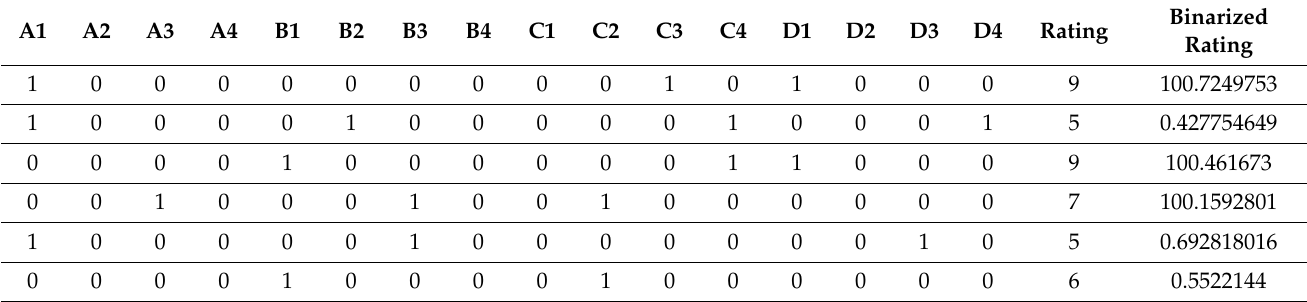
Table 2. First six rows of the input matrix for OLS